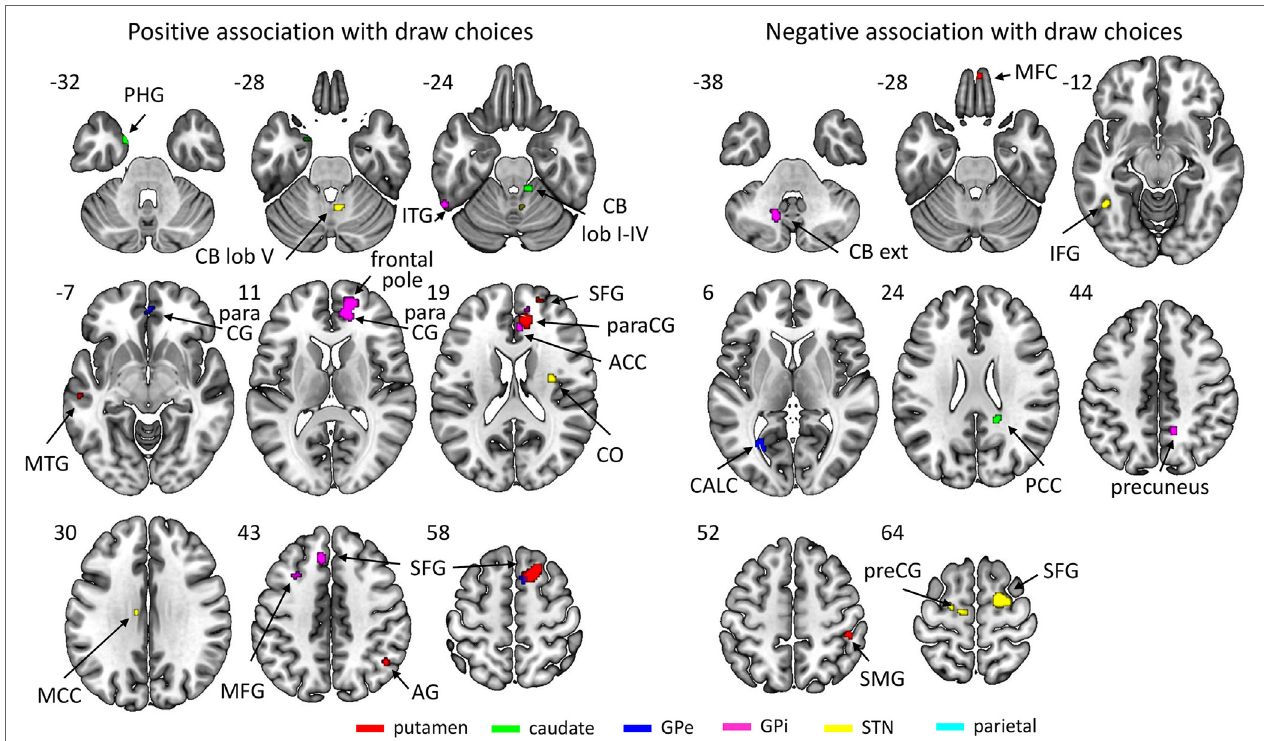
FigUre 4 | Regions of which the connectivity strength with their respective region of interest was associated positively (left) or negatively (right) with the number of draw choices across participants. The key for the abbreviations can be found in the notes of Table 3